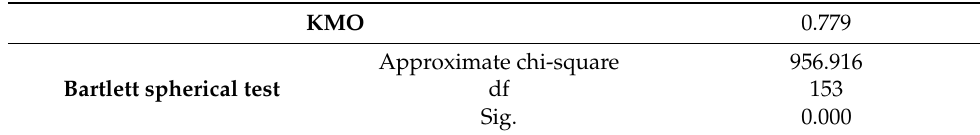
Table 2. Results of the KMO and Bartlett spherical